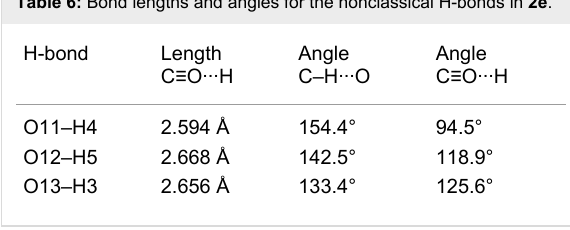
Table 6: Bond lengths and angles for the nonclassical H-bonds in 2e .